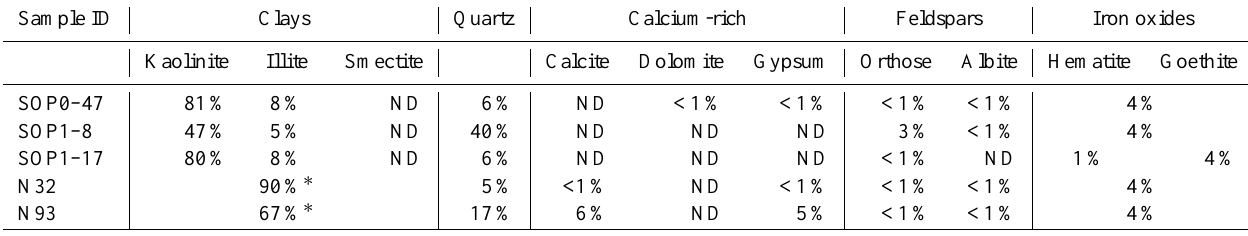
Table 2. Mineralogical composition (percentage by mass) of the five samples from the Banizoumbou and the Tamanrasset sites. The estimated uncertainties associated with the identification of the different mineral species are for clays ± 8–20%, quartz ± 3%, calcite ± 3%, dolomite ±